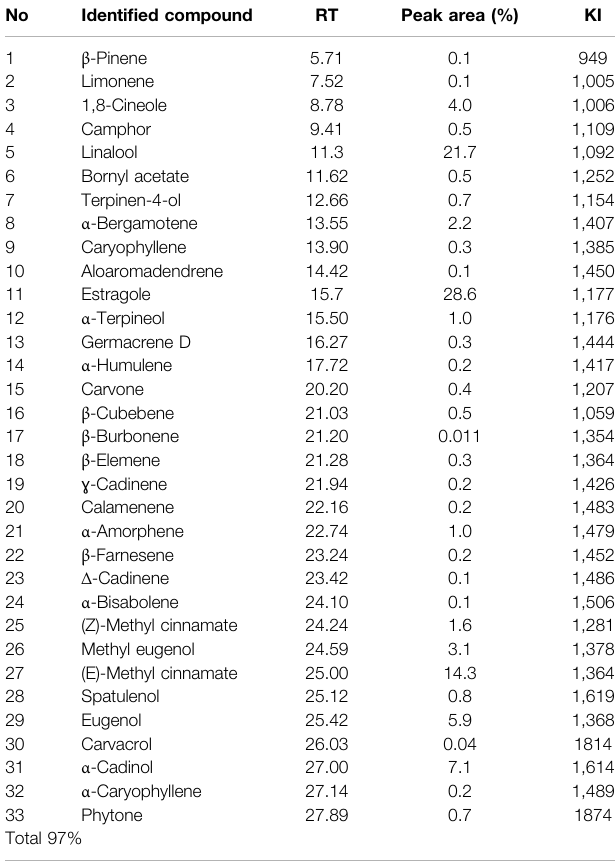
TABLE 2 | Chemical composition of O. basilicum essential